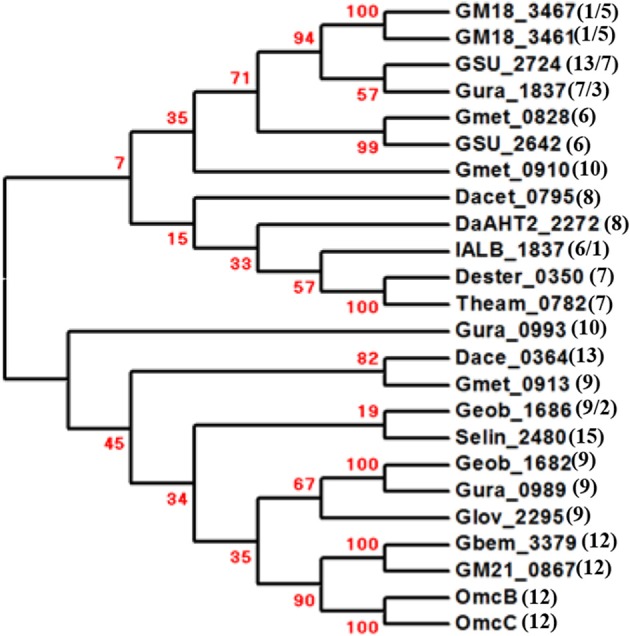
Phylogenetic analyses of the Pcc outer-membrane c-type cytochromes. The phylogenetic trees were constructed with MEGA6 and confidence levels are indicated in the major nodes by the bootstrap values (%) in red. The numbers in the parenthesis next to the locus tags are the numbers of their predicted typical (CX2CH)/atypical (CX3-15CH) heme-binding motifs of the c-type cytochromes. The tree is not drawn to scale.